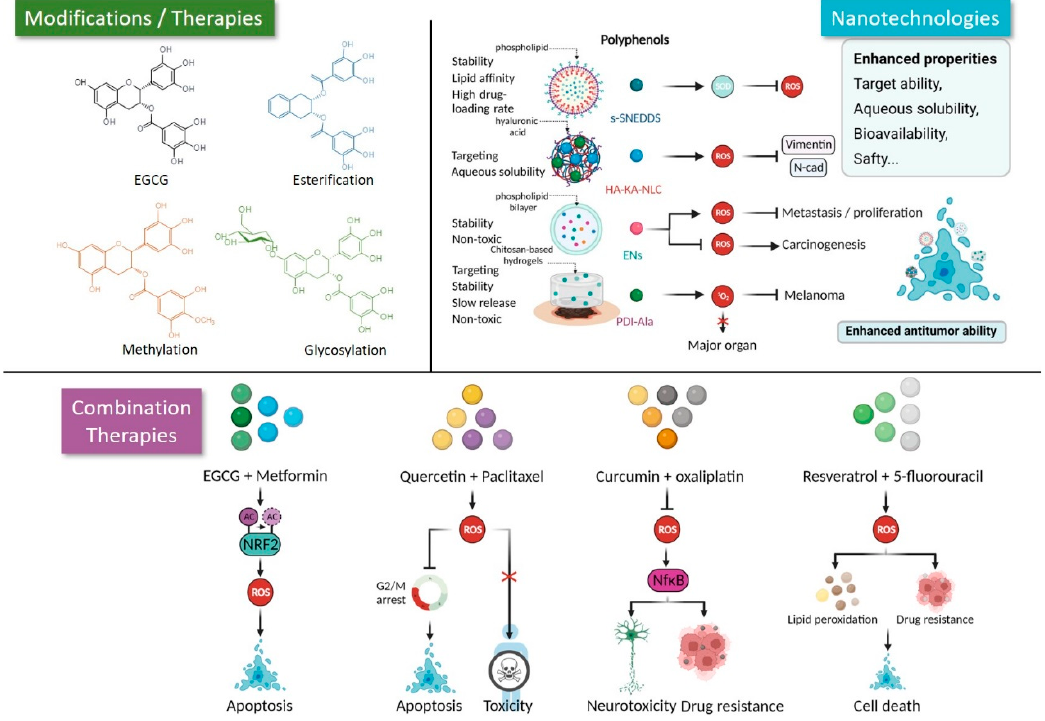
Figure 5. Novel strategies promote the application of polyphenols in cancer therapy. Structural modifications, such as esterification, methylation, and glycosylation, protect polyphenols from rapid degradation and promote their bioactivities. Nanotechnologies can make up the inherent limitations of polyphenols and support targeting delivery of them to specific tumor lesions with minor side effects. Combination therapies achieve efficient tumor eliminate via enhanced ROS-mediated mechanisms.